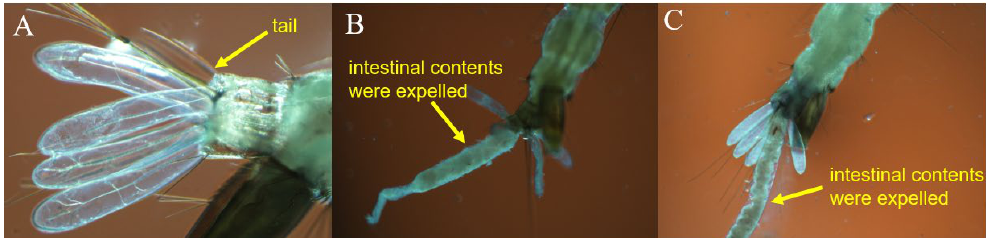
Figure 8. Observation of the larval tail: ( A ) the negative control group; ( B ) the SOP-2q treated group; ( C ) the SOP-2r treated group.